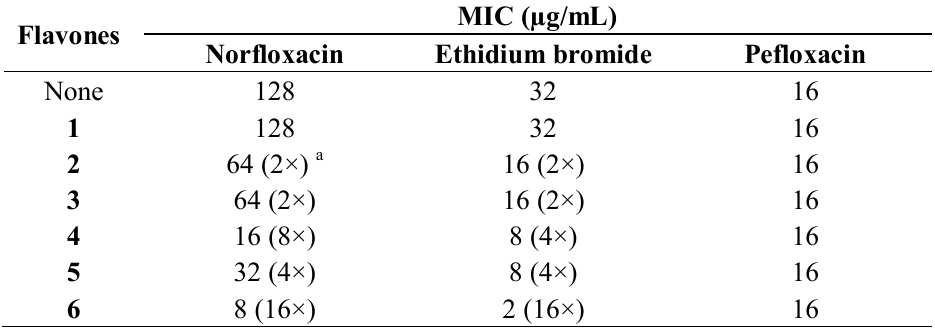
Table 1. Minimum inhibitory concentrations (MICs) of antibiotics and ethidium bromide against Staphylococcus aureus strain SA-1199B, in the absence and presence of